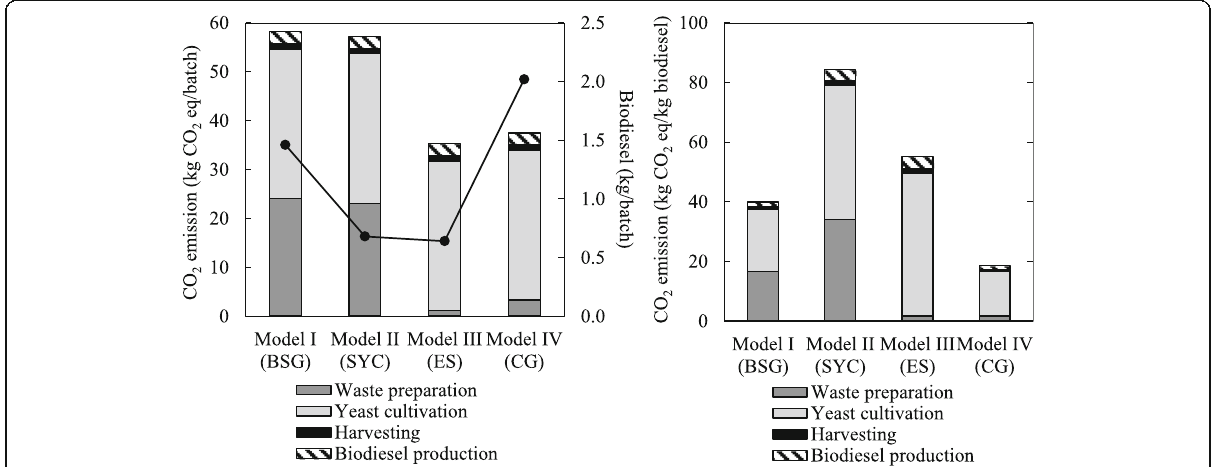
Fig. 5 Comparison of total CO 2 emission and CO 2 emission per 1 kg-biodiesel of bioconversion of agro-industrial wastes into biodiesel. Symbols with line represent biodiesel